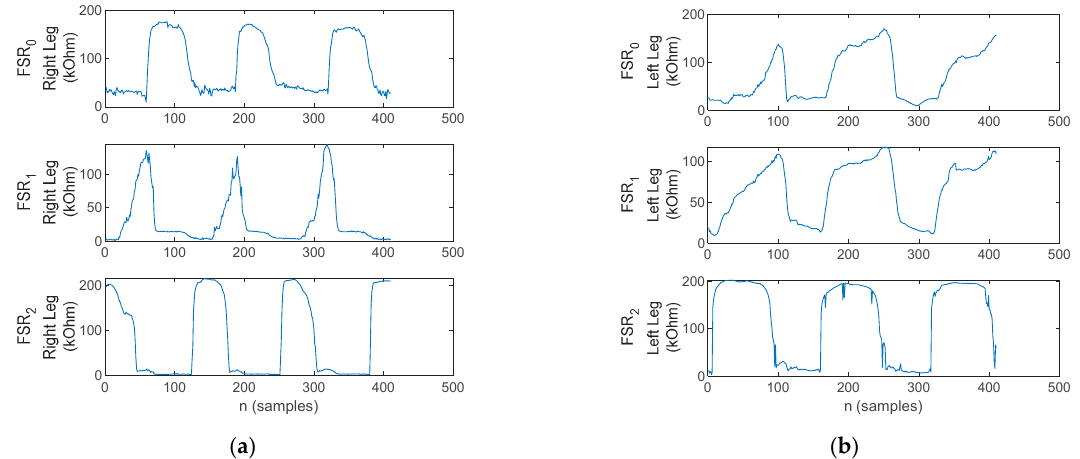
Figure 14. The arm balance MA and VA waveforms during the walking trials, with the red triangles indicating the MA maxima. ( a ) Healthy control—the MA exhibits a U-shaped variation and the VA accounts for smaller variation, and ( b ) PD patient—the MA exhibits a larger number of local peaks with reduced amplitude and the VA accounts for larger variation. The time-domain plots further enable the assessment of the biomechanical and temporal parameters, used for motor evaluation in accordance with the UPDRS and MDS-UPDRS rating scales for Parkinson’s Disease. Heel strike accounts for initial contact with the ground at the stance initiation phase under a physiological gait pattern. Heel strike identification is performed by following the plantar pressure progression pattern. The identification of a heel strike is provided by a heel → metatarsal arch → toe pressure progression detection. For illustration, the FSR signals during gait initiation, with heel strike and flat-foot strike, are plotted in Figure 15.